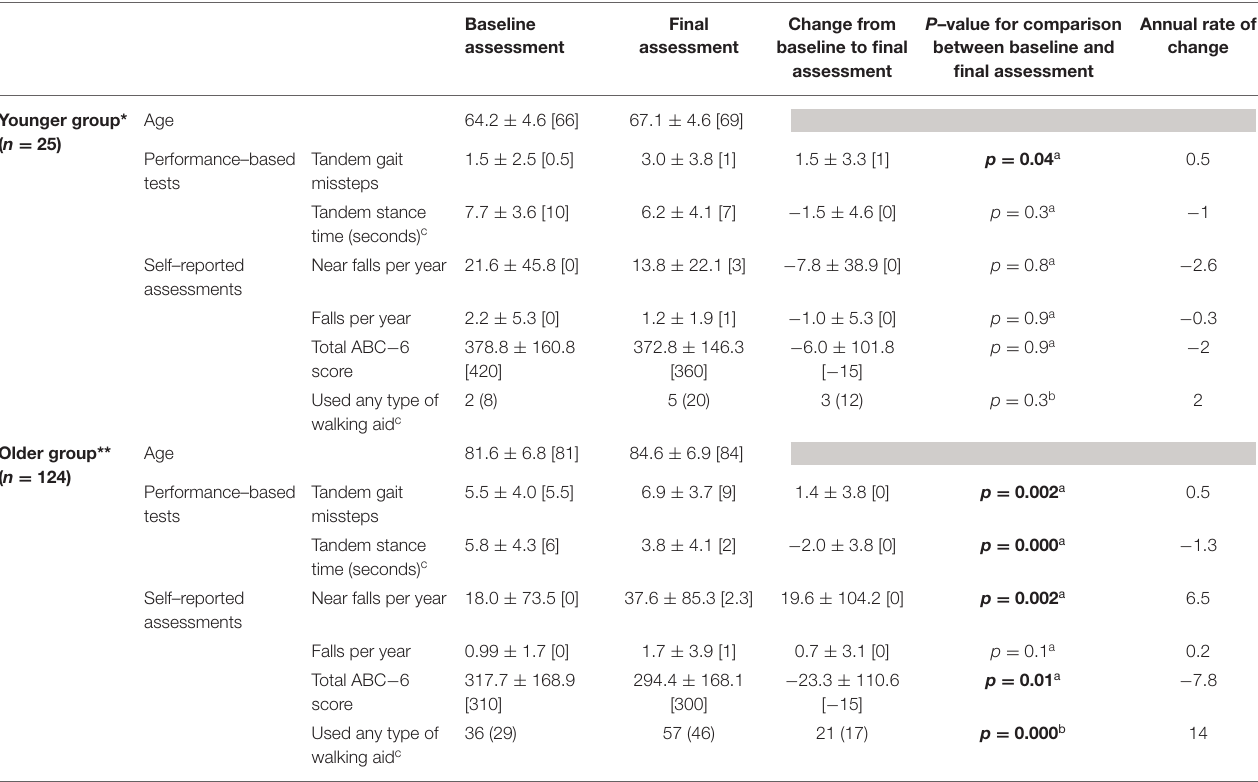
TABLE 5 | Gait and balance differences stratified by age